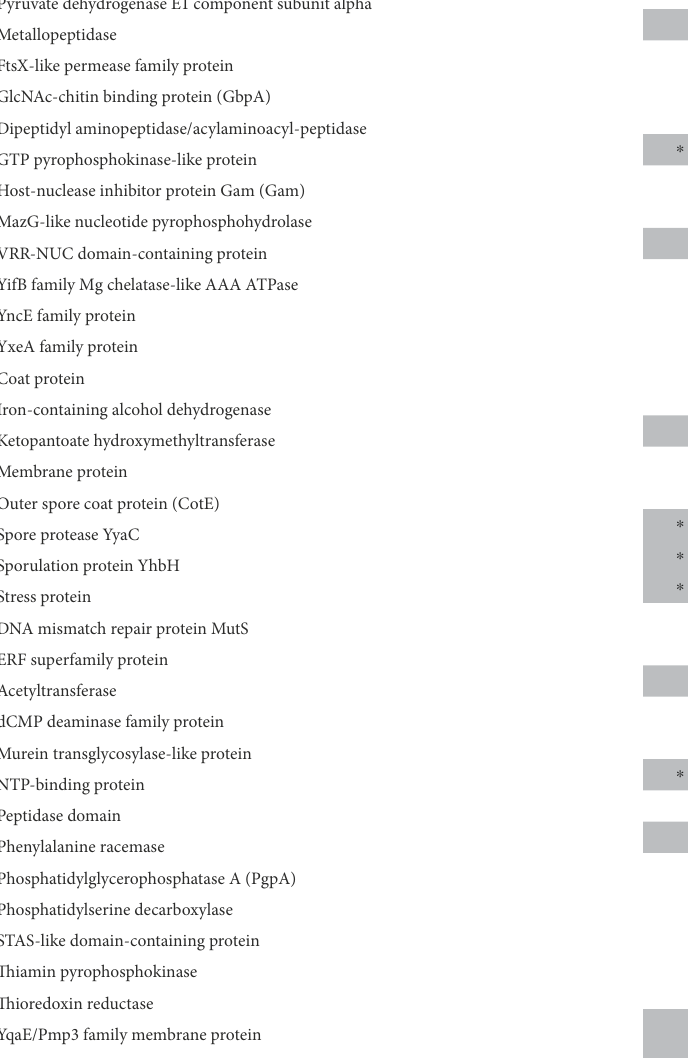
GlcNAc-chitin binding protein (GbpA) Dipeptidyl aminopeptidase/acylaminoacyl-peptidase GTP pyrophosphokinase-like protein Host-nuclease inhibitor protein Gam (Gam) MazG-like nucleotide pyrophosphohydrolase VRR-NUC domain-containing protein